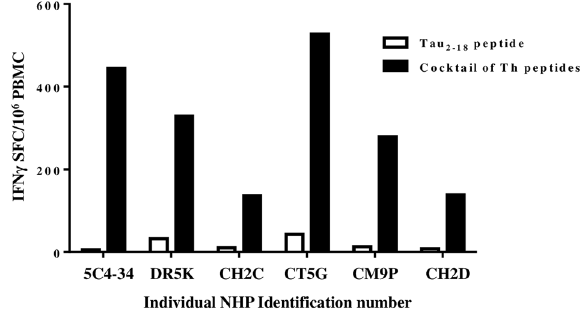
Fig. 3 AV-1980R/A induced strong cellular responses speci fi c to MultiTEP Th epitopes but not Tau 2-18 peptide in adult non-human primates. INF γ producing T cells were detected in PBMC of vaccinated NHPs by ELISPOT assay. The individual monkeys are plotted on the x-axis, and the number of INF γ -positive T cells is plotted on the y-axis. The PBMC restimulation is done by either the cocktail of peptides derived from the MultiTEP platform (black bars) or by the Tau 2-18 peptide (white